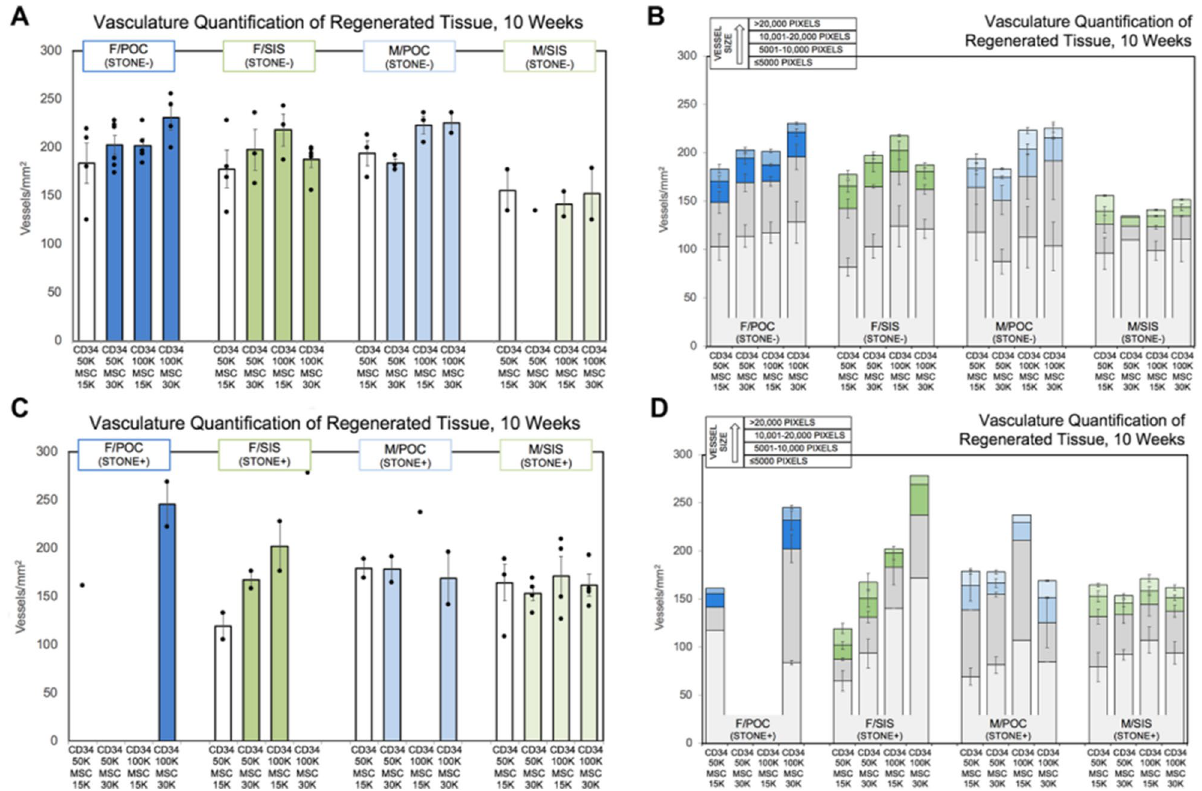
Figure 1. Analysis of vasculature in regenerated female and male rat bladder tissue sections10 weeks post- augmentation. Average vasculature per group is measured in vessels/mm 2 for ( A , B ) stone negative (S−) and ( C , D ) stone positive (S+) rats augmented with either a POC or SIS scaffold seeded at a specific cellular concentration with MSC and CD34 + HSPC at varying ratios (n = 4–6 before subsets). All female graft groups (S− and S+) and M/POC (S−) demonstrate a possible trend towards increased vasculature at greater seeding densities. In assessment without subsets, the increase for F/POC (S− and S+ animals) was significant [CD34- 50/MSC15 179.2 ± 17.0 vs CD34-100/MSC30 235.5 ± 10.4 (p < 0.01)]. B/D) Vessels are shown grouped by size. Trends toward increases in some size groups were observed (F/POC S− and S+, and M/POC S− 5001–10,000 size; F/SIS S− and S+ ≤ 5000 size). In assessment without subsets, the increases for F/POC (S− and S+ animals) and F/SIS (S− and S+ animals) were significant [F/POC CD34-50/MSC15 41.7 ± 9.9 vs CD34-100/MSC30 84.6 ± 14.0 (p < 0.05); F/SIS CD34-50/MSC15 76.3 ± 7.4 vs CD34-100/MSC15 130.9 ± 12.2 (p < 0.01) and CD34- 100/MSC30 129.7 ± 11.7 (p < 0.01)]. Error bars represent ± animals (TSB range 106–739), only 2/7 (M/POC) and 3/16 (M/SIS) male S+ animals reached that level of TSB. For the M/POC composite grafts (TSB range 1–172), only animals with the highest numbers of stones (8, 11) had a TSB > 100 (127, 172). In M/SIS S+ animals (TSB range 1–633), TSB was < 100 for 13/16 (stone number 1–9) and > 100 for 13/16, with high stone numbers for two of the three > 100 (stone number 1, 13, 17) (Fig. 2B). The